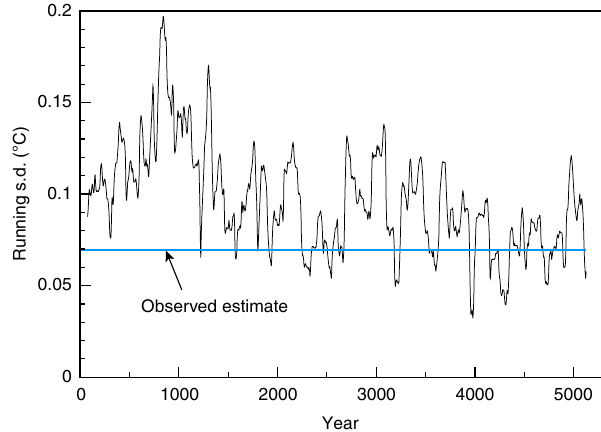
Figure 3 | Running standard deviation of global temperatures from the CM3 control run compared with observations. The running standard deviations from CM3 are based on overlapping 141-year segments of 10-yr running mean global surface air temperatures. A long-term drift in the control run temperatures is filtered out by removing separate linear trends over years 1–1530 and 1531–5200 and recombining the residuals to form a single 5200-year series. The drift is removed, followed by computation of 10-year running means, followed by computation of the running standard deviations of the overlapping 141-year smoothed time series segments. The blue line depicts the s.d. of 10-year running mean residual anomalies for observations (that is, observed minus CMIP5 All-Forcing ensemble mean, 141-year smoothed series). The figure illustrates the time-varying nature of the interdecadal variability in the CM3 control run. Unit: (cid:2)